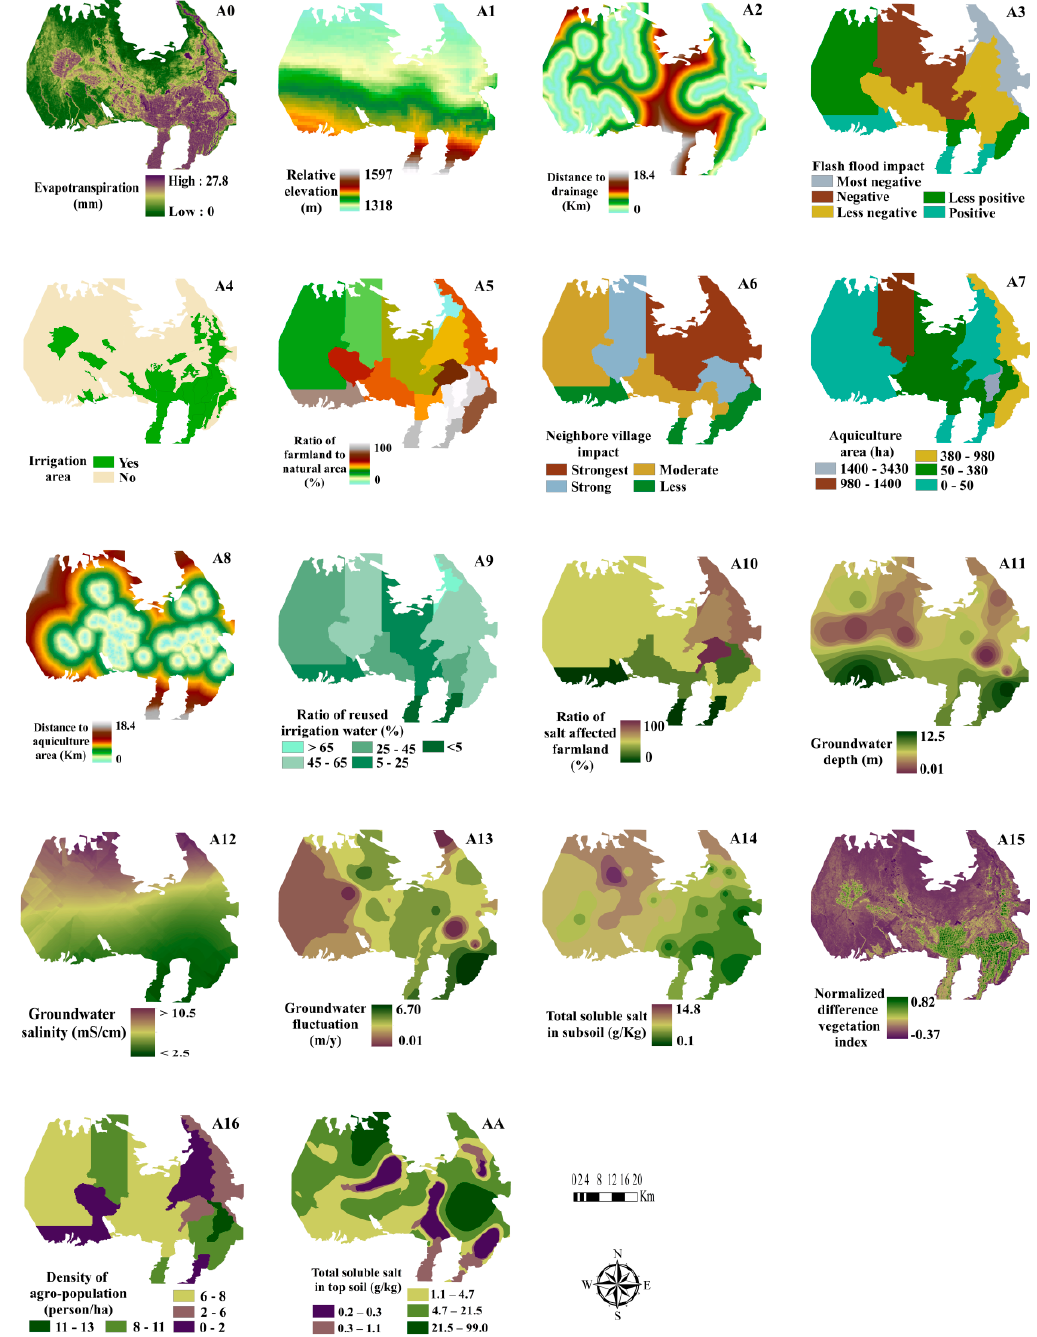
Figure 4. Raster maps of the risk receptor and risk parameters in the Keriya Oasis.